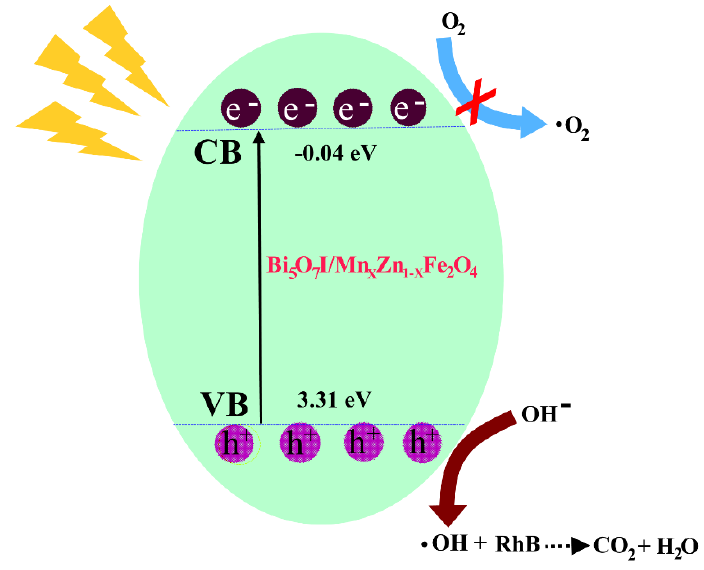
Figure 11. Schematic of the possible reaction mechanism of the photocatalytic procedure.